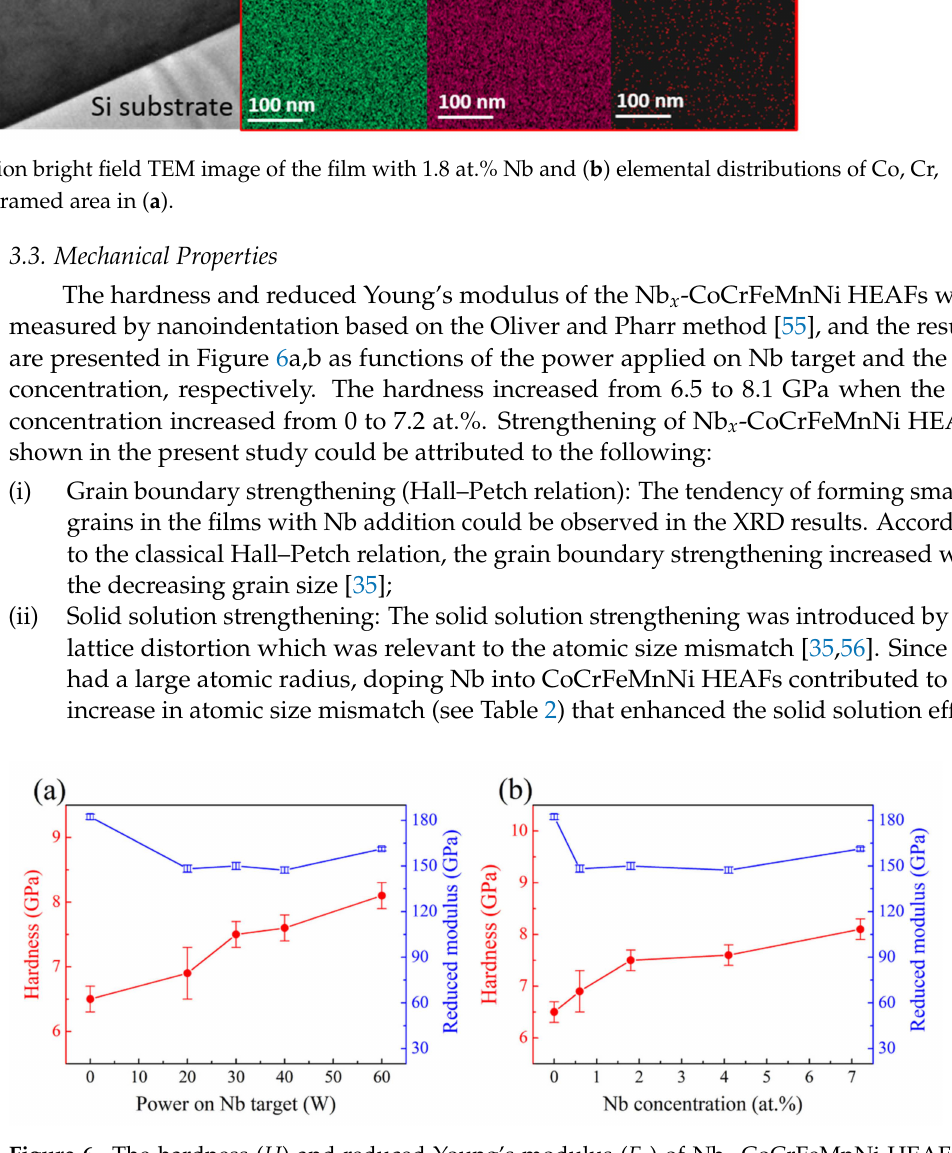
Figure 6. The hardness ( H ) and reduced Young’s modulus ( E r ) of Nb x -CoCrFeMnNi HEAFs as functions of ( a ) the power applied on Nb target and ( b ) Nb